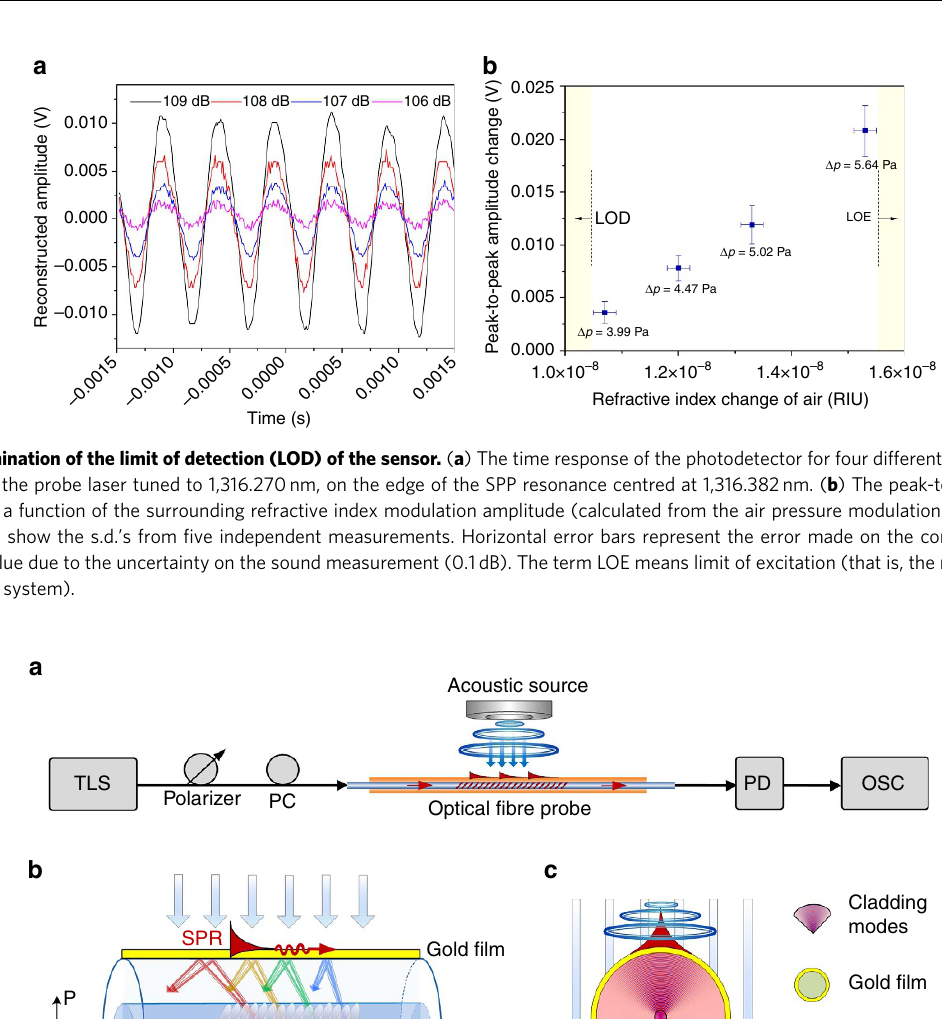
NATURE COMMUNICATIONS|7:13371|DOI: